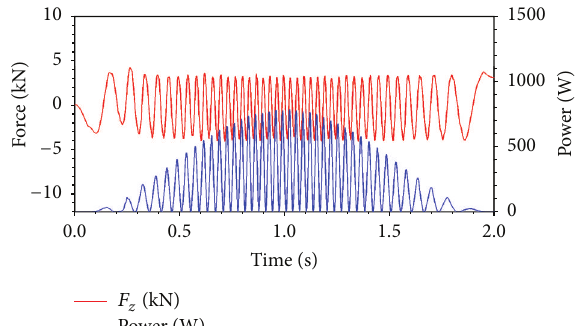
Figure 25: Applied force and power.